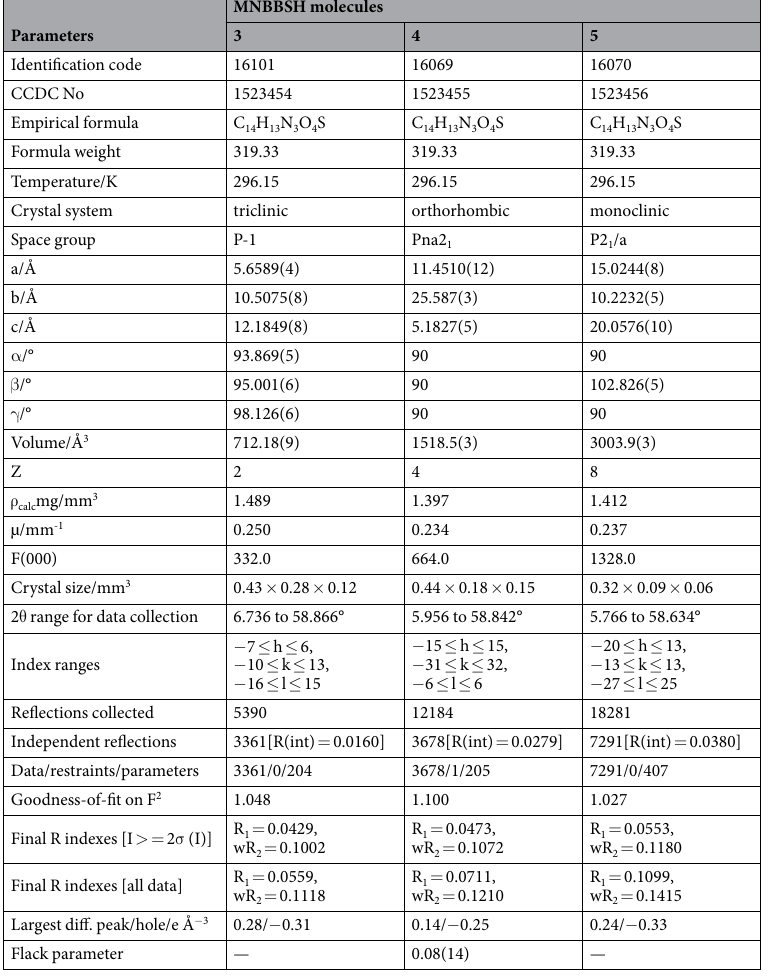
Table 1. Crystal parameters and structure refinement of the MNBBSH